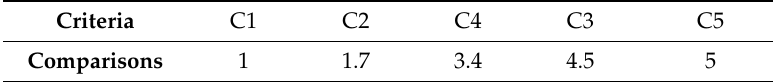
Table 1. Comparisons of